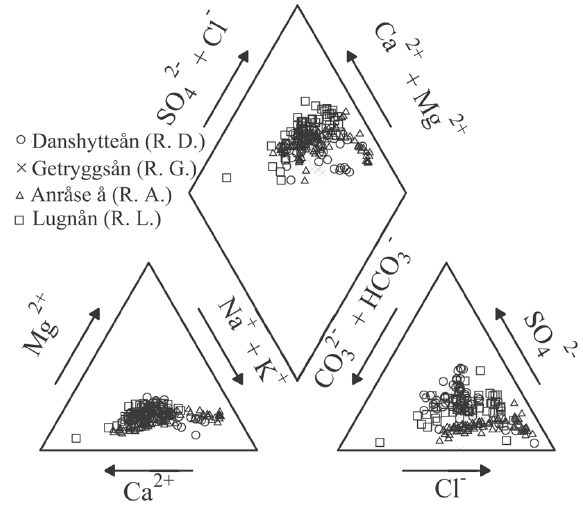
Fig. 3. Piper diagram, where River Anr˚ase ˚a is represented by tri- angles, River Lugn˚an by open squares, River Danshytte˚an by open circles and River Getryggs˚an by